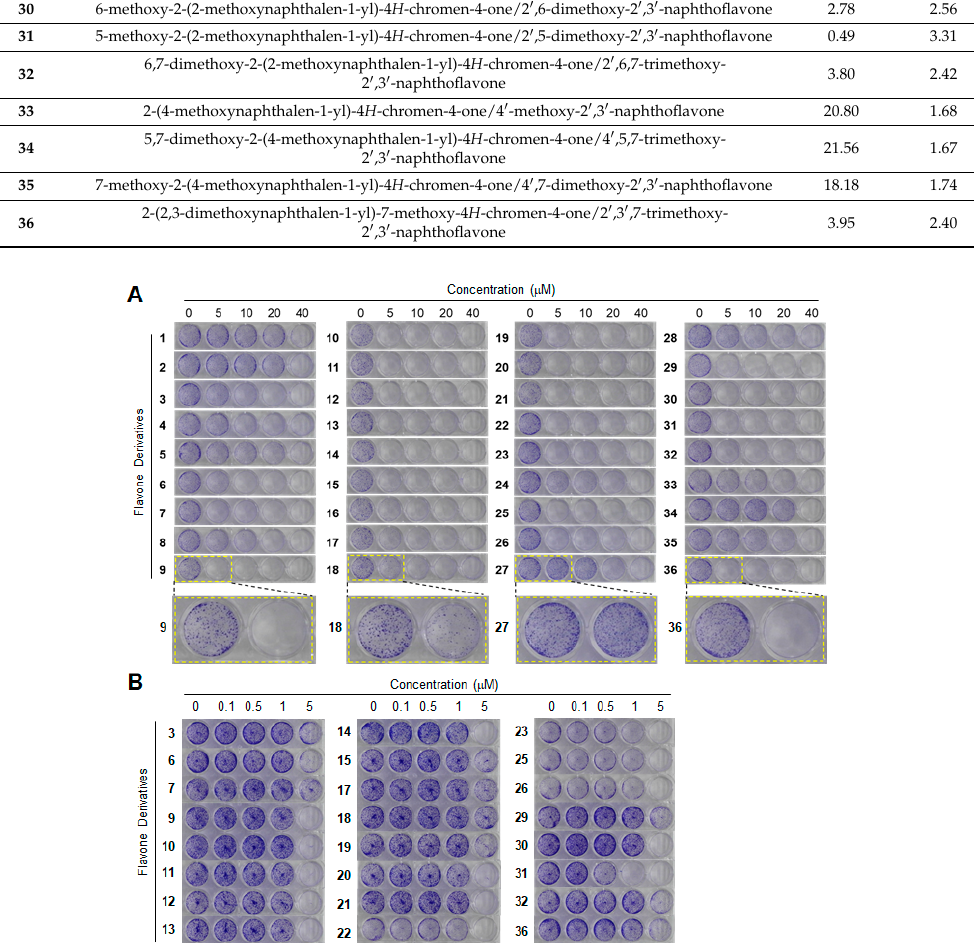
Figure 1. Effects of flavone derivatives on the inhibition of clonogenicity of HCT116 colon cancer cells. Cells were treated with derivative compounds at 0, 5, 10, 20 and 40 µ M ( A ) or at 0, 0.1, 0.5, 1 and 5 µ M ( B ). The dashed lines show the enlarged images.